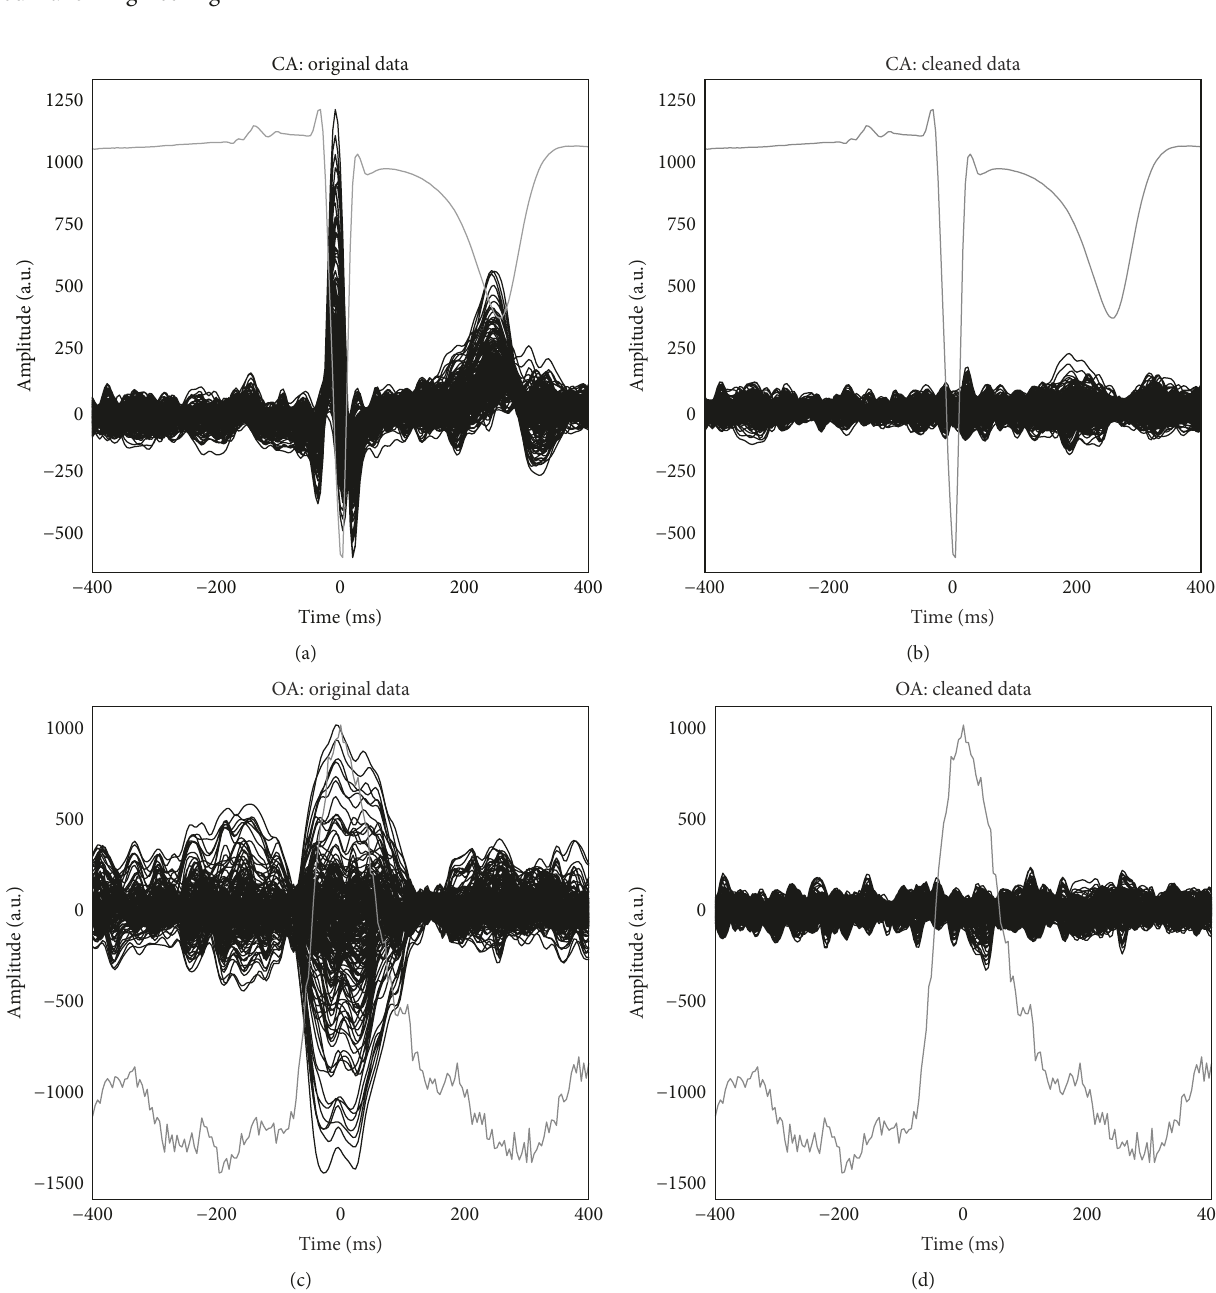
Figure 6: Plot showing ECG/EOG artifact removal on averaged MEG data for a representative subject before (a, c) and after (b, d) artifact removal. Averages were aligned based on peak onsets from the ECG (a, b) or EOG (c, d) signal, which is superimposed in